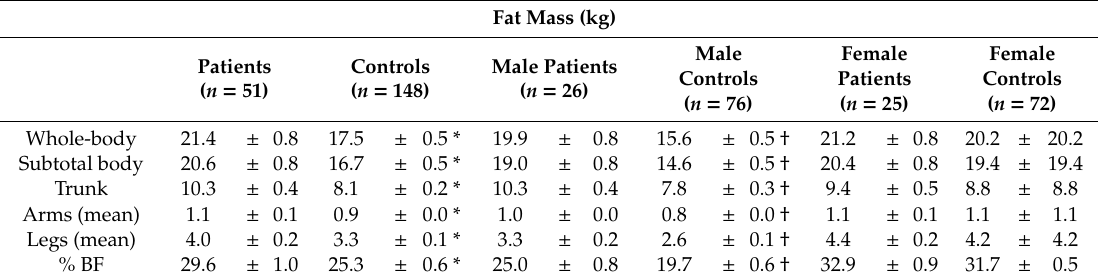
Table 3. Adiposity (fat mass) indices by group and